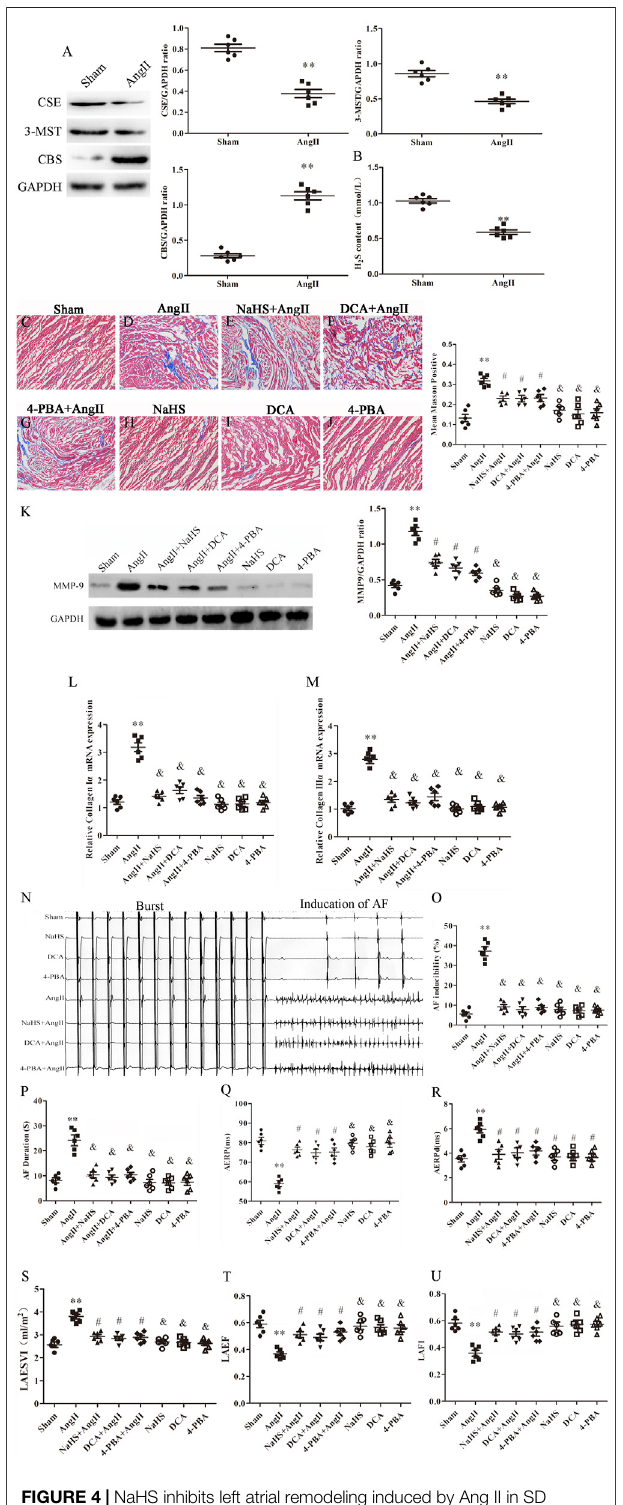
FIGURE 4 | NaHS inhibits left atrial remodeling induced by Ang II in SD rats and is associated with the inhibition of the Warburg effect and ERS. (A) Representative Western blotting and relative densitometry analysis of CSE, 3- MST and CBS with GAPDH as the loading control in the rats left atrial